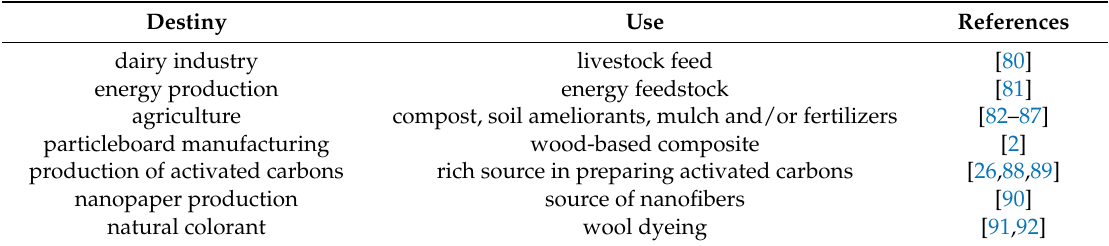
Table 2. Functional applications of almond